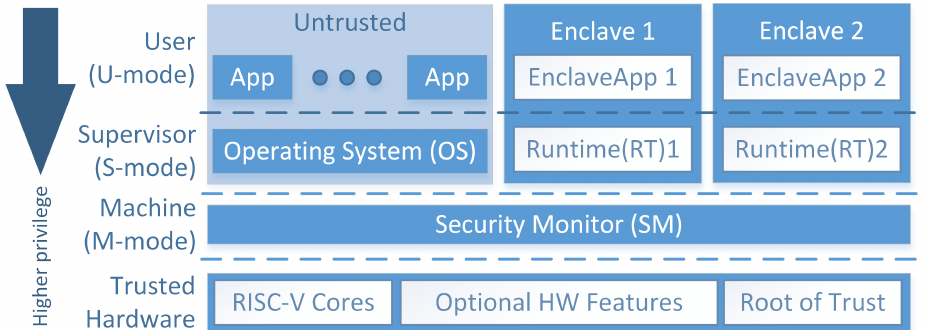
Figure 3. Overview of a Keystone system setup, based on [56]. The distinction between untrusted and trusted execution environments is presented, along with support for multiple secure enclaves and their runtimes. The privilege level for each RISC-V mode is marked. The security Monitor, operating on M-mode, being common for both execution environments, is the manager of context switching. Required trusted hardware is